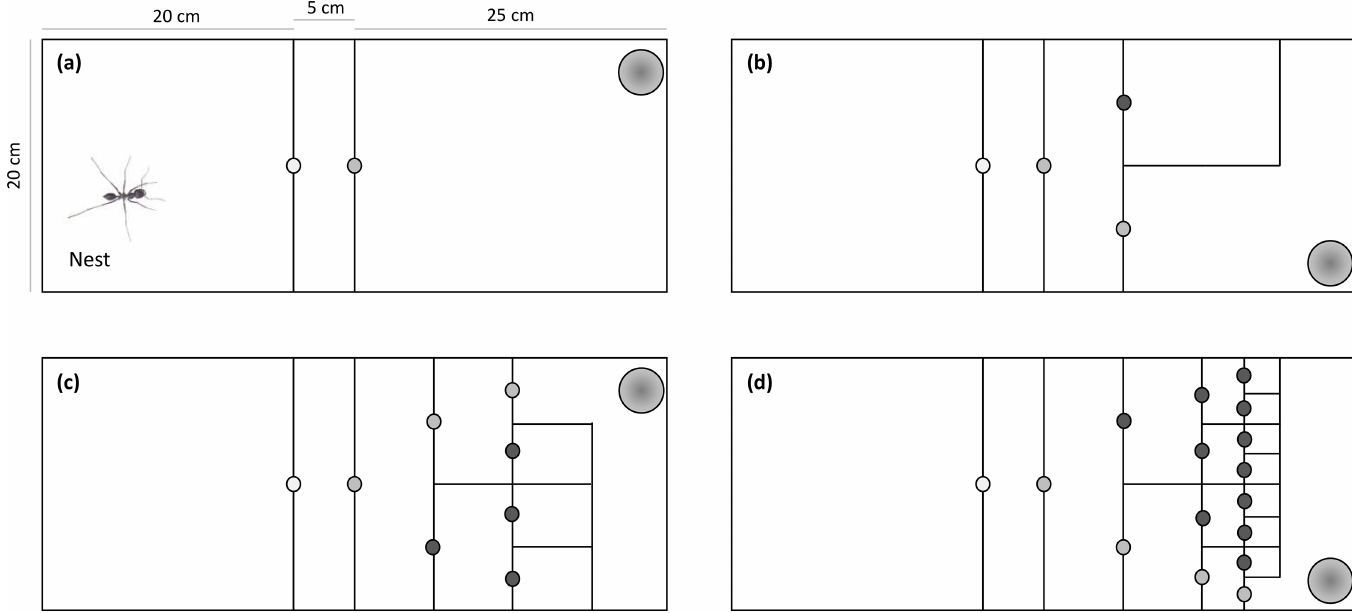
Fig 1. Illustration of a nest and a maze of complexity levels (a) 0, (b) 1, (c) 2 and (d) 3. Each circle representsa passageand a decisionto make (light gray ones are correct decision,leadingto the food reward, and dark grey ones are wrong decisions). The larger circle on the right upper (a, c) side or right lower side (b, d) represents the food reward(honey). The correct number of decisions, includingthe decisionto enter the maze are 1, 2, 3, and 4 for complexity levels 0 to 3, respectively.The total numberof decisionsare 1, 3, 7, and 15 for the same complexity levels. Mazes includedeither right or left turns as the correct ones, which were randomly appliedper